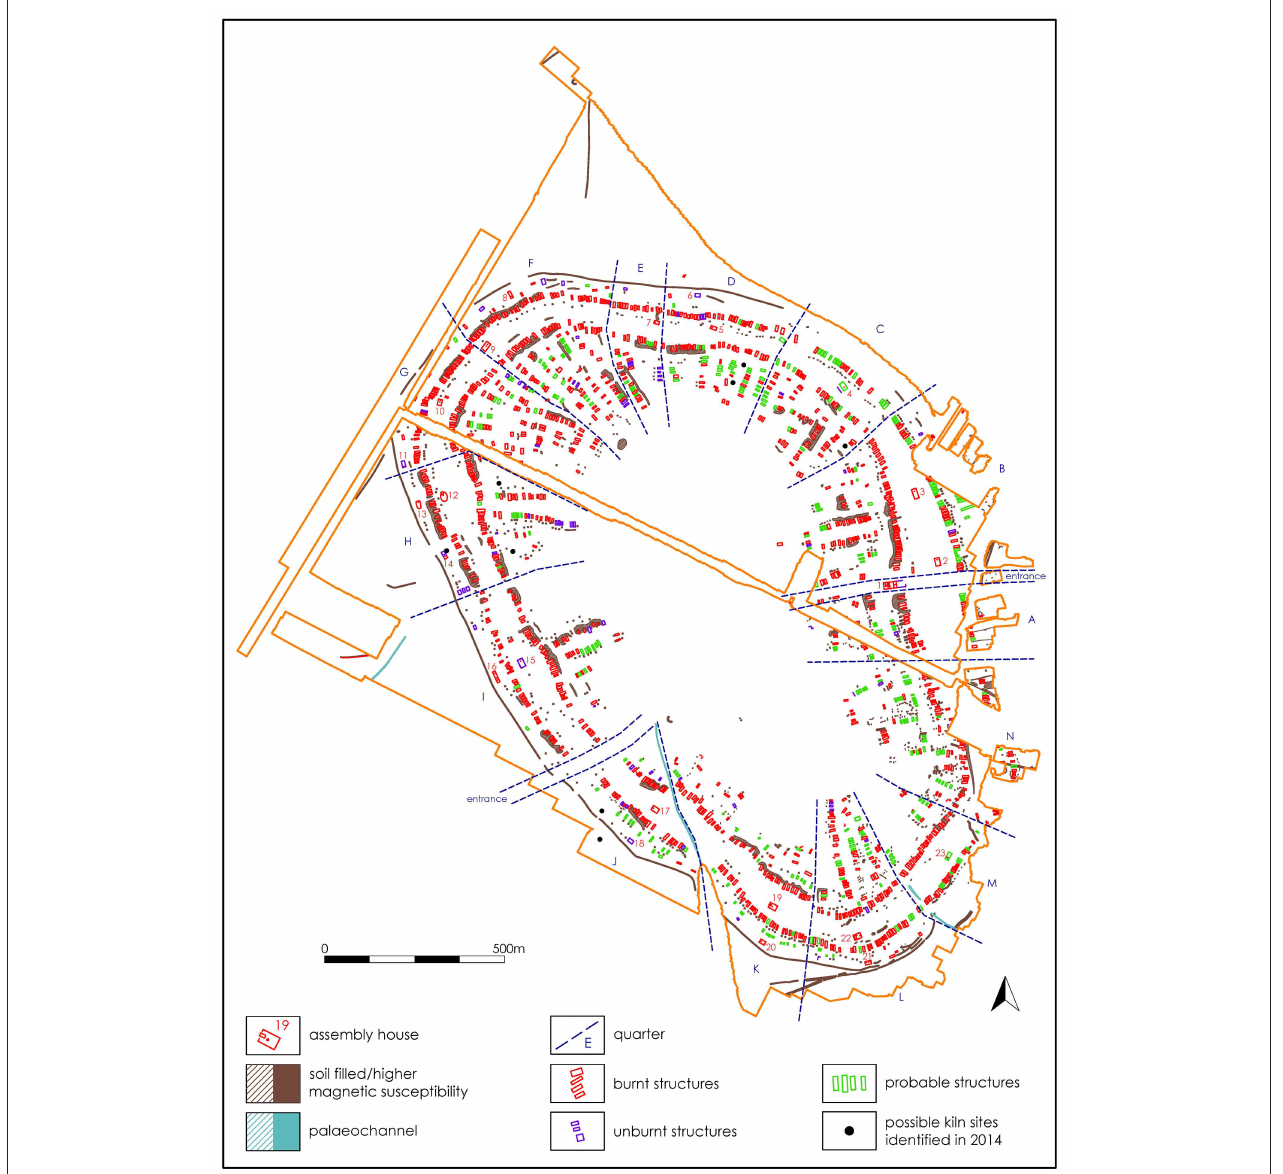
FIGURE 9 | Interpretative plan of the Nebelivka megasite, showing the overall survey area and geophysical anomalies interpreted as burnt houses, unburnt houses, probable houses, and possible kiln sites. Assembly Houses are numbered. The borders of the Quarters are shown, with Quarters identified by letter. (Y. Beadnell, based upon data from D. Hale,